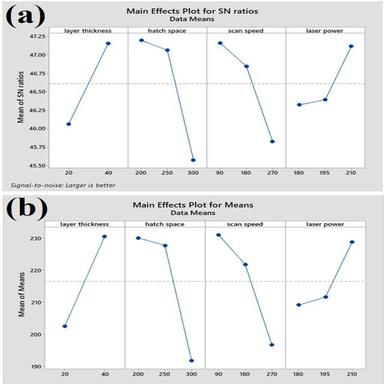
(a) The S/N ratio and (b) mean values for the effective parameters on the maximum micro-hardness values as determined by S/N and ANOVA analyses.